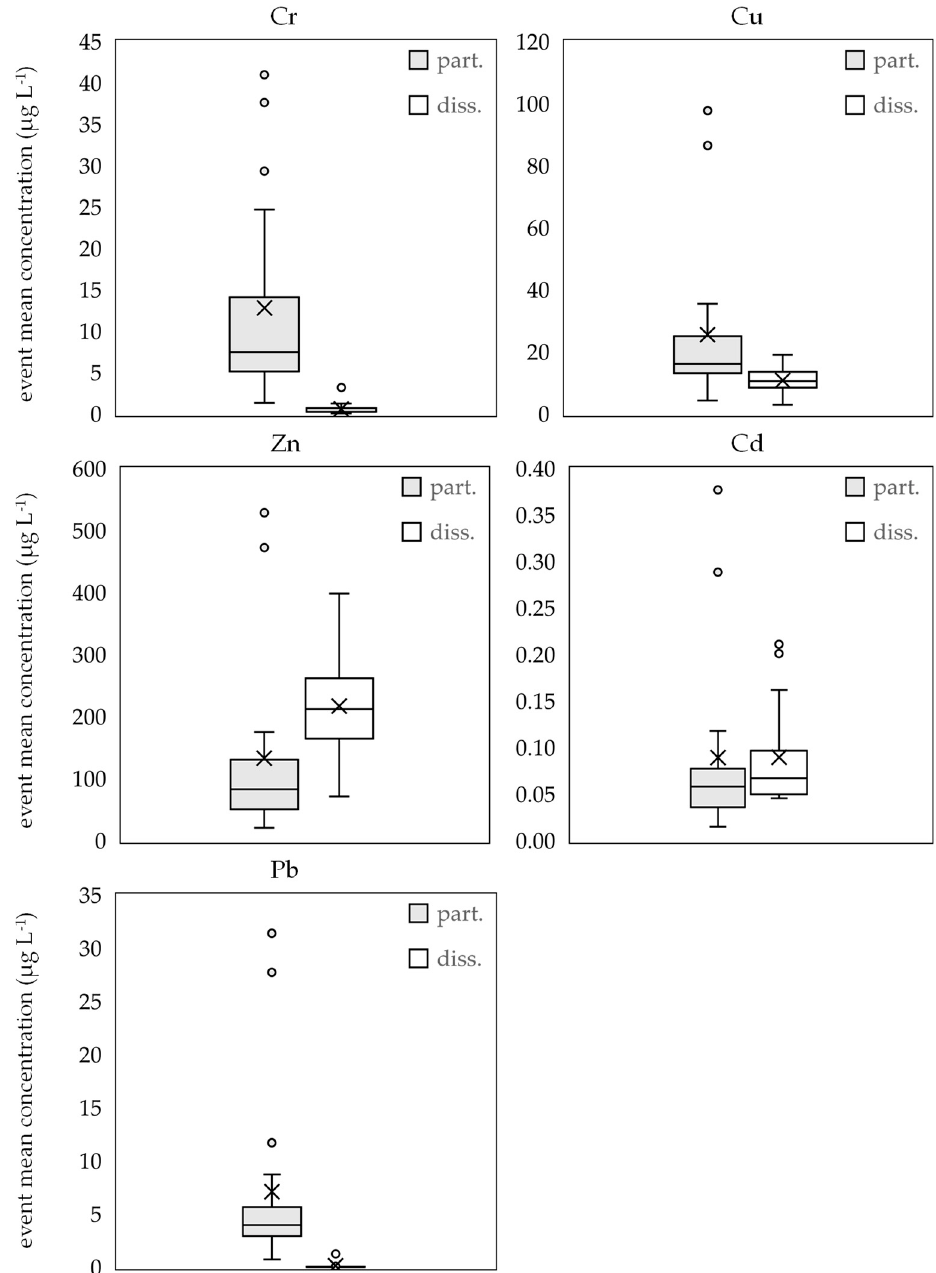
Figure 6. Distribution of metal event mean concentrations on an event basis (n = 17) distinguished between particulate- bound and dissolved fraction.